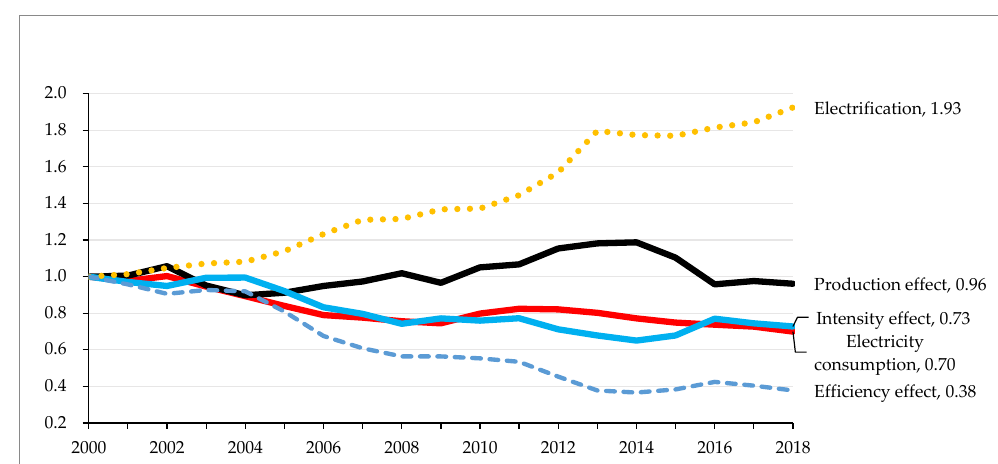
Figure A2. Textile and leather electricity consumption LMDI results (fixed base year, multiplicative).